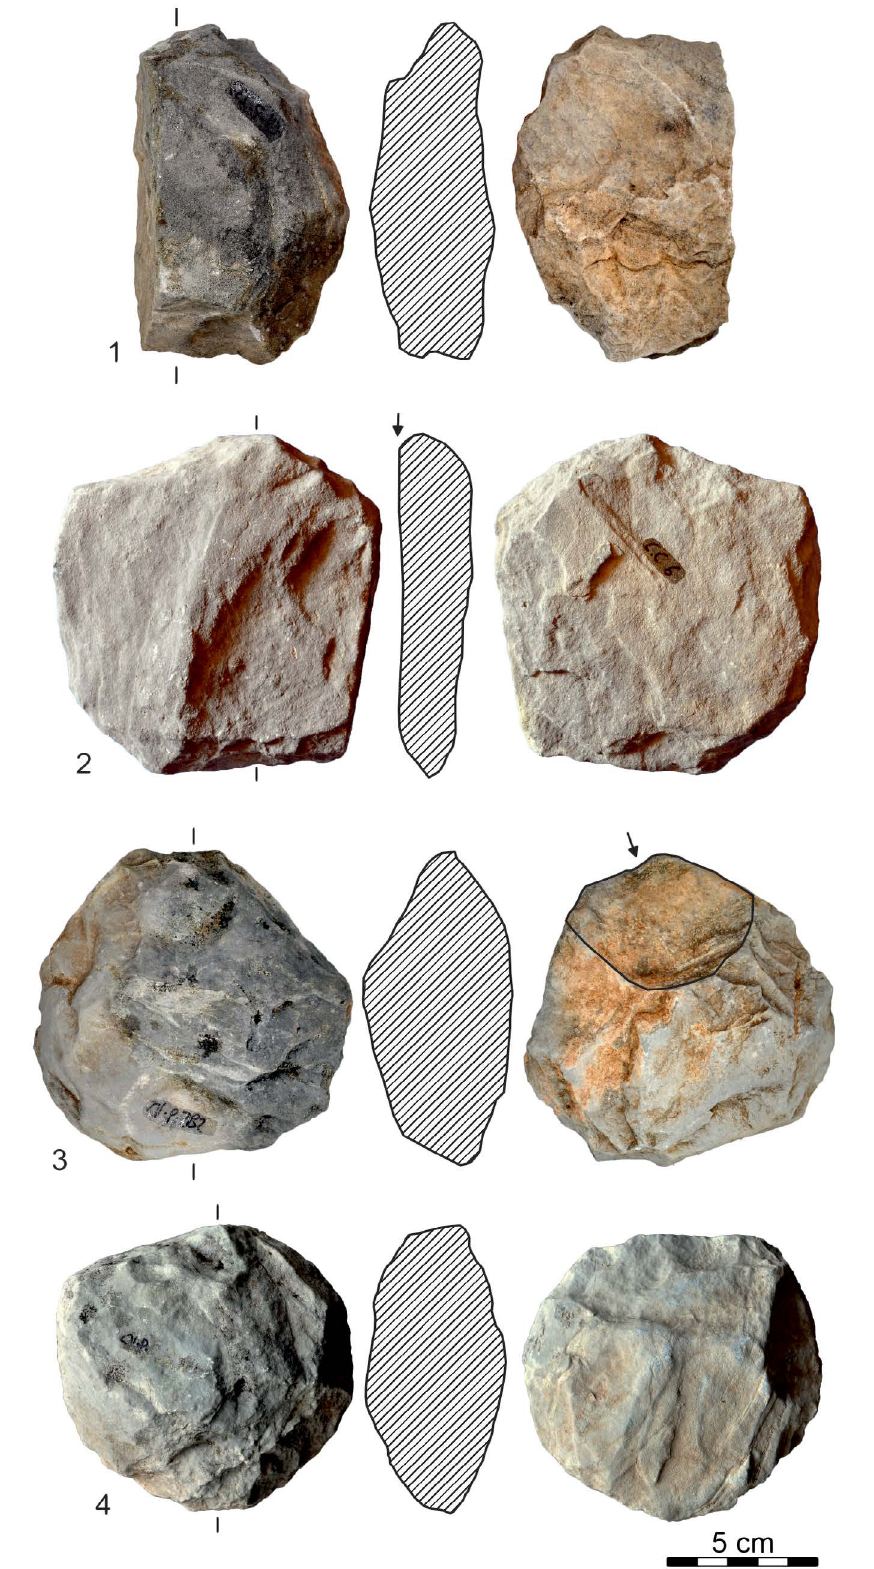
Figure 6. Different types of preforms documented in the quarry. 1. Medially fracture; 2. Longitudinal fracture; 3. Exceeded strike and 4. Unviable. (Scale bar is 5 cm